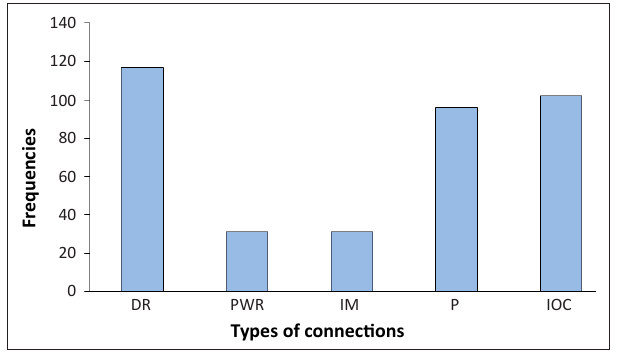
FIGURE 1: Summary of data counts for all four teachers in different